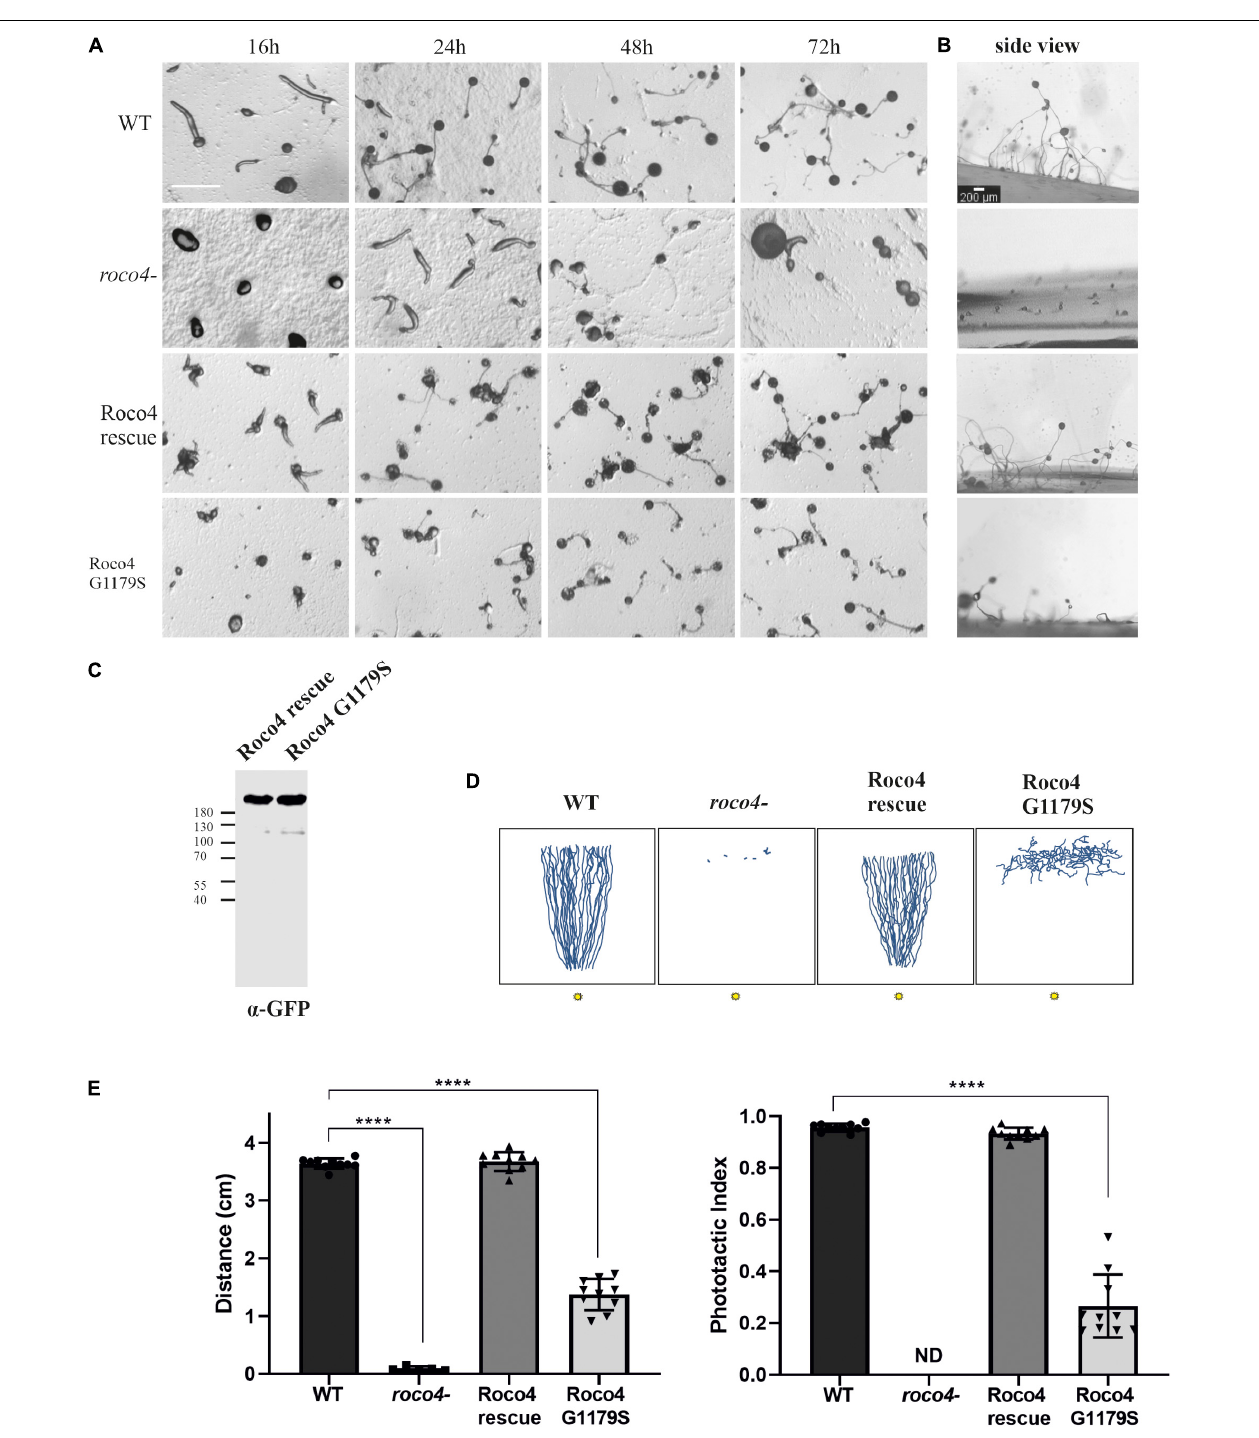
FIGURE 1 | Roco4 mutants have impaired development and phototaxis. (A) WT, roco4 -, Roco4 rescue and Roco4 G1179S cells were plated on NN agar plates and images were taken at the indicated time points. Scale bar indicates 200 µ m. (B) Side view of fruiting bodies after the completion of the developmental cycle. Scale bar indicates 200 µ m. (C) Western blot of lysate of cells expressing Roco4-GFP and Roco4 G1179S-GFP cells. (D) Representative illustration of slug tracks. The 3 cm wide trench where cells started is positioned horizontally at the top and the 1 mm wide light slit is located at the bottom of the image. Illustrations of the scanned slug tracks have been made via ImageJ. (E) Phototactic properties of the indicated strains. Shown are the total distance moved (left panel) and the phototactic index (ratio of the total distance moved and the direct distance moved to the light. The data shown are the means of 20–25 tracks. **** indicates P < 0.005 differences from WT in an ANOVA